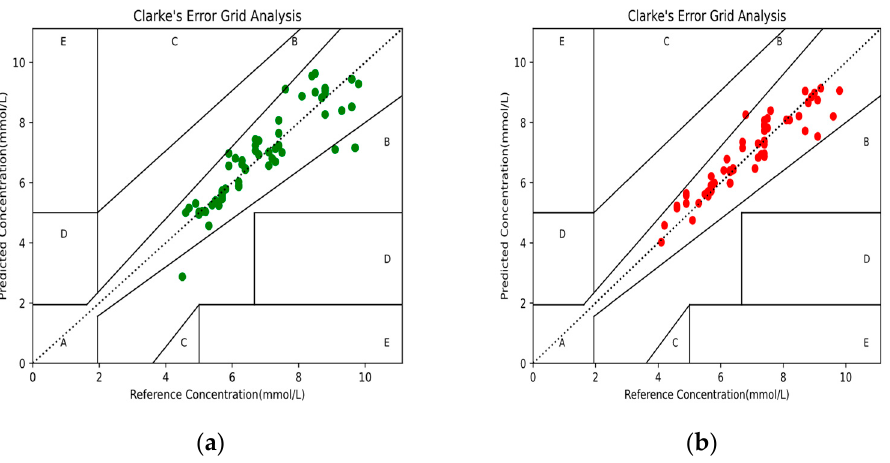
Figure 7. The Clarke error grid analysis of the predicted BG values: ( a ) BG values based on the MPR4 model; ( b ) BG values based on the BPNN model. Table 2. Performance comparison of the MPR4 and BPNN models.